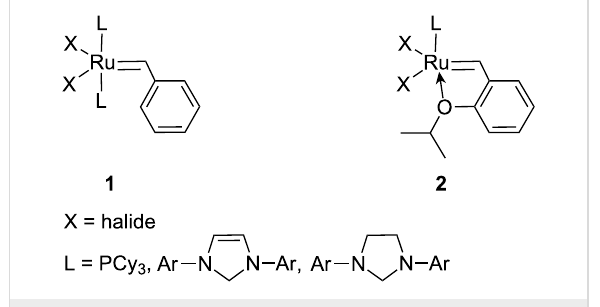
for the reaction with the support surface (linkers) are used. This usually requires a sophisticated synthetic procedure. Moreover, the changes in the Ru coordination sphere may lead to the decrease in catalyst activity (e.g., the exchange of chloro ligands for carboxylates [10,11]).